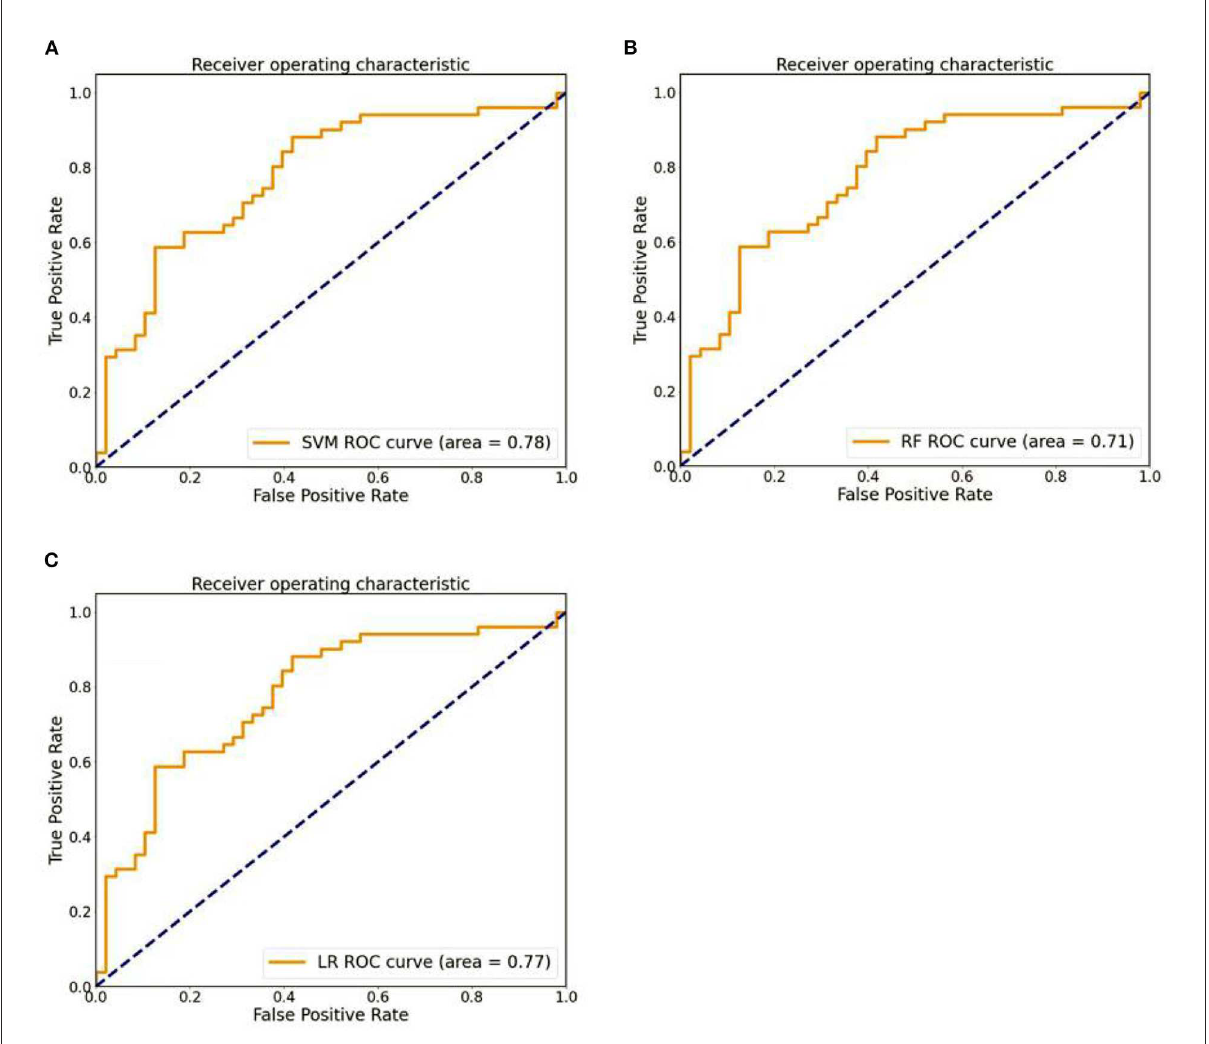
FIGURE3 (A) The ROC curves of SVM models. (B) The ROC curves of RF models. (C) The ROC curves of LR